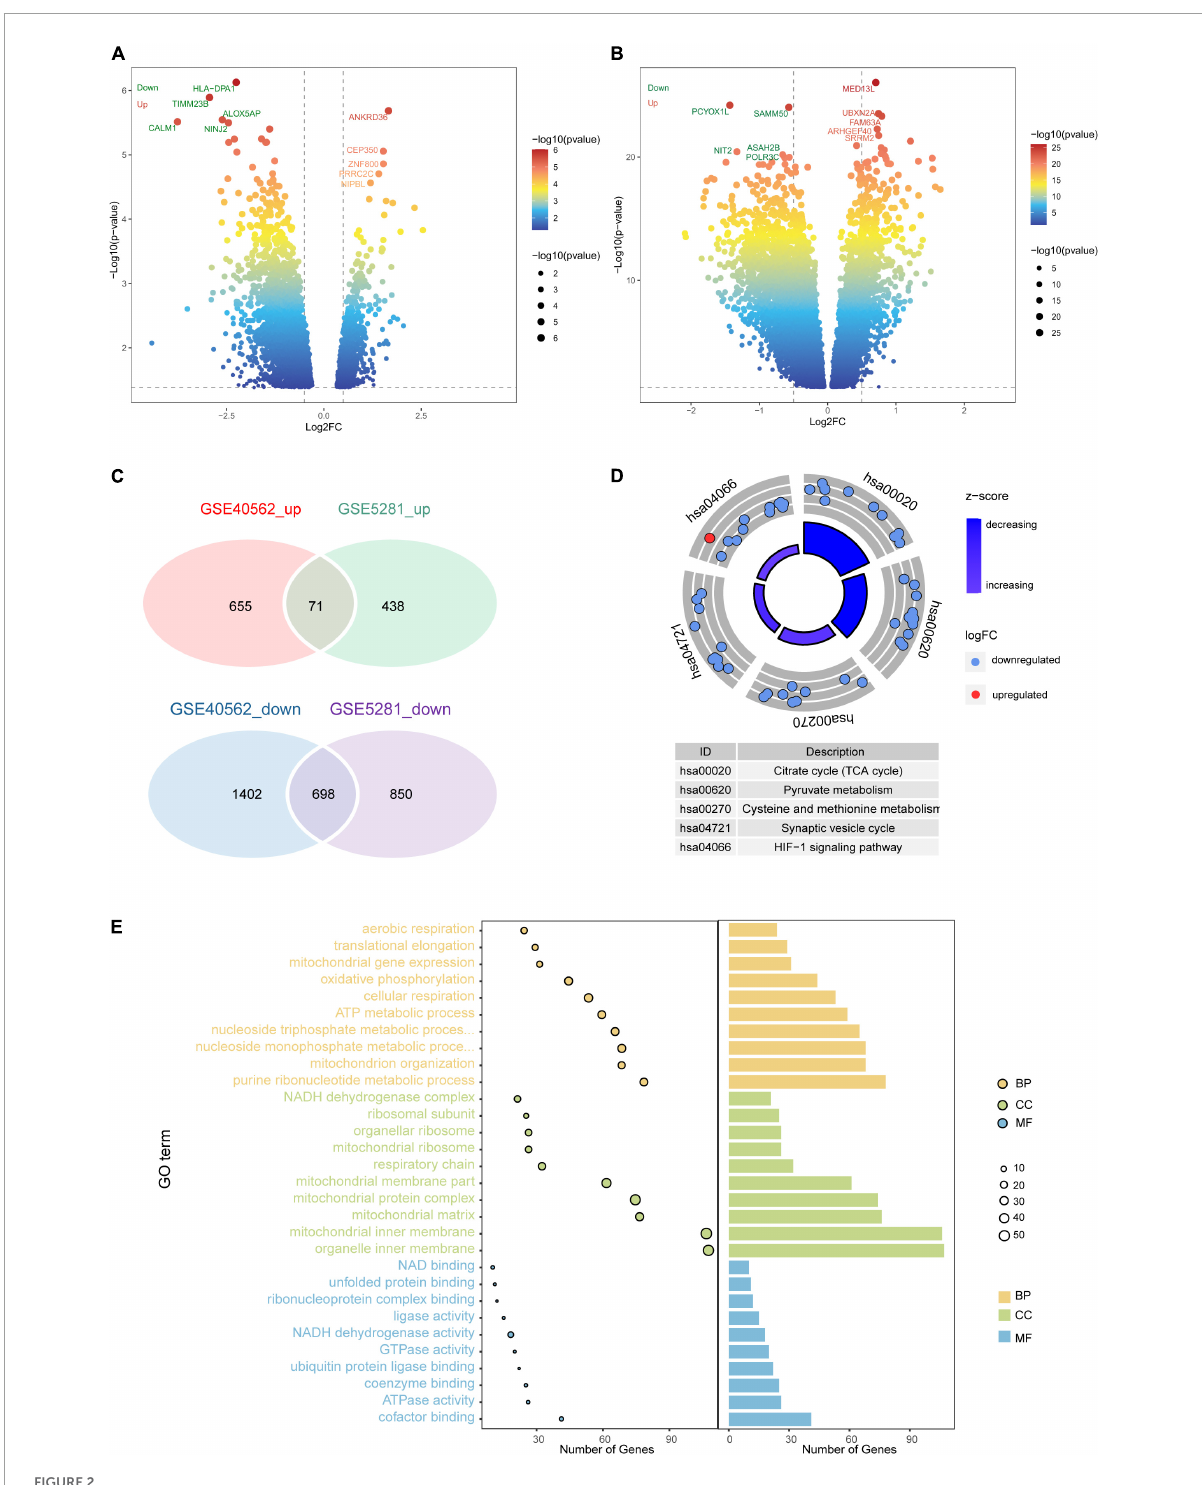
FIGURE2 Differential gene expression and enrichment analysis. Volcano plot of differentially expressed genes (DEGs) between (A) patients with Alzheimer’s disease (AD) and controls in GSE40562, or (B) patients with sleep disorder and controls in GSE5281. Red color indicates upregulated genes; green, downregulated genes. (C) Venn diagrams showing common up- or downregulated genes in AD, sleep disorder, and controls. (D) Intersecting DEGs were predicted to be involved in five pathways. (E) Protein functional analysis in terms of biological processes, cellular components, and molecular functions. GO, Gene Ontology; BP, biological process; CC, cellular component; MF, molecular function; log 2 FC, log 2 (fold